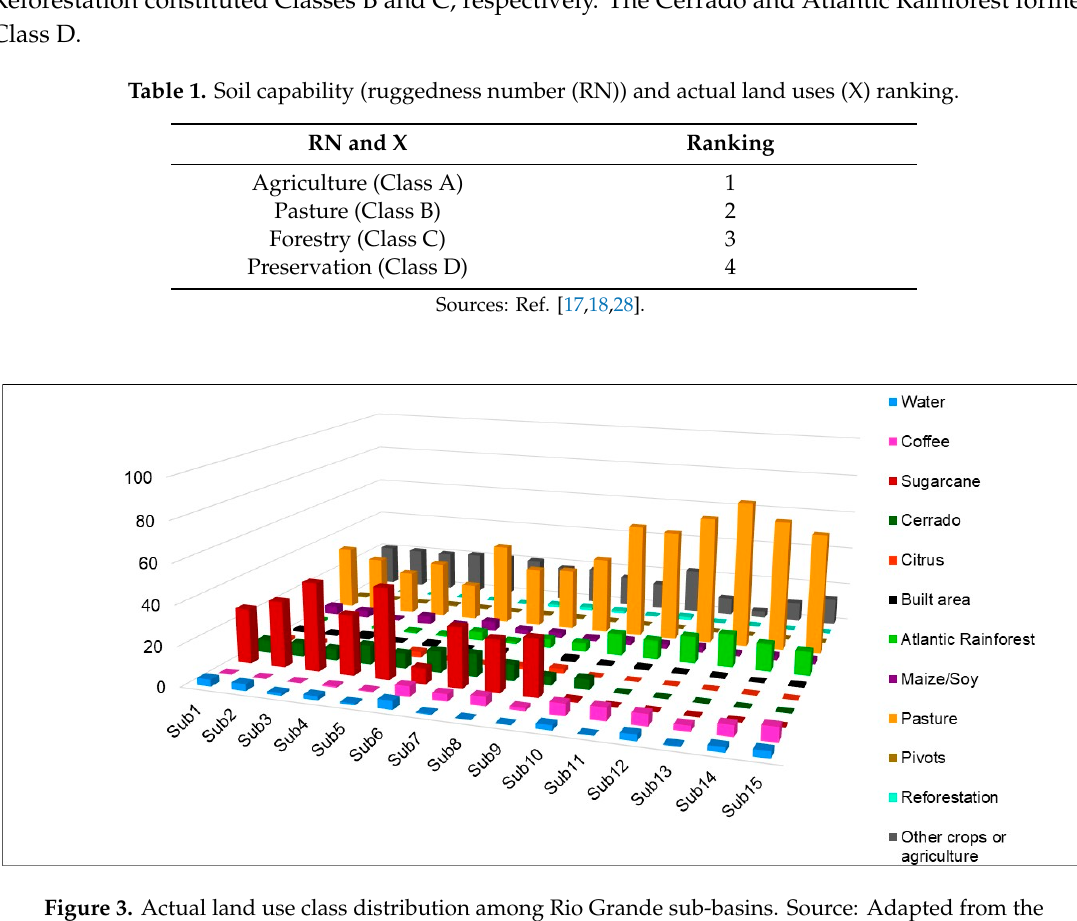
Figure 3. Actual land use class distribution among Rio Grande sub-basins. Source: Adapted from the Brazilian National Water Agency—Ref. [23].